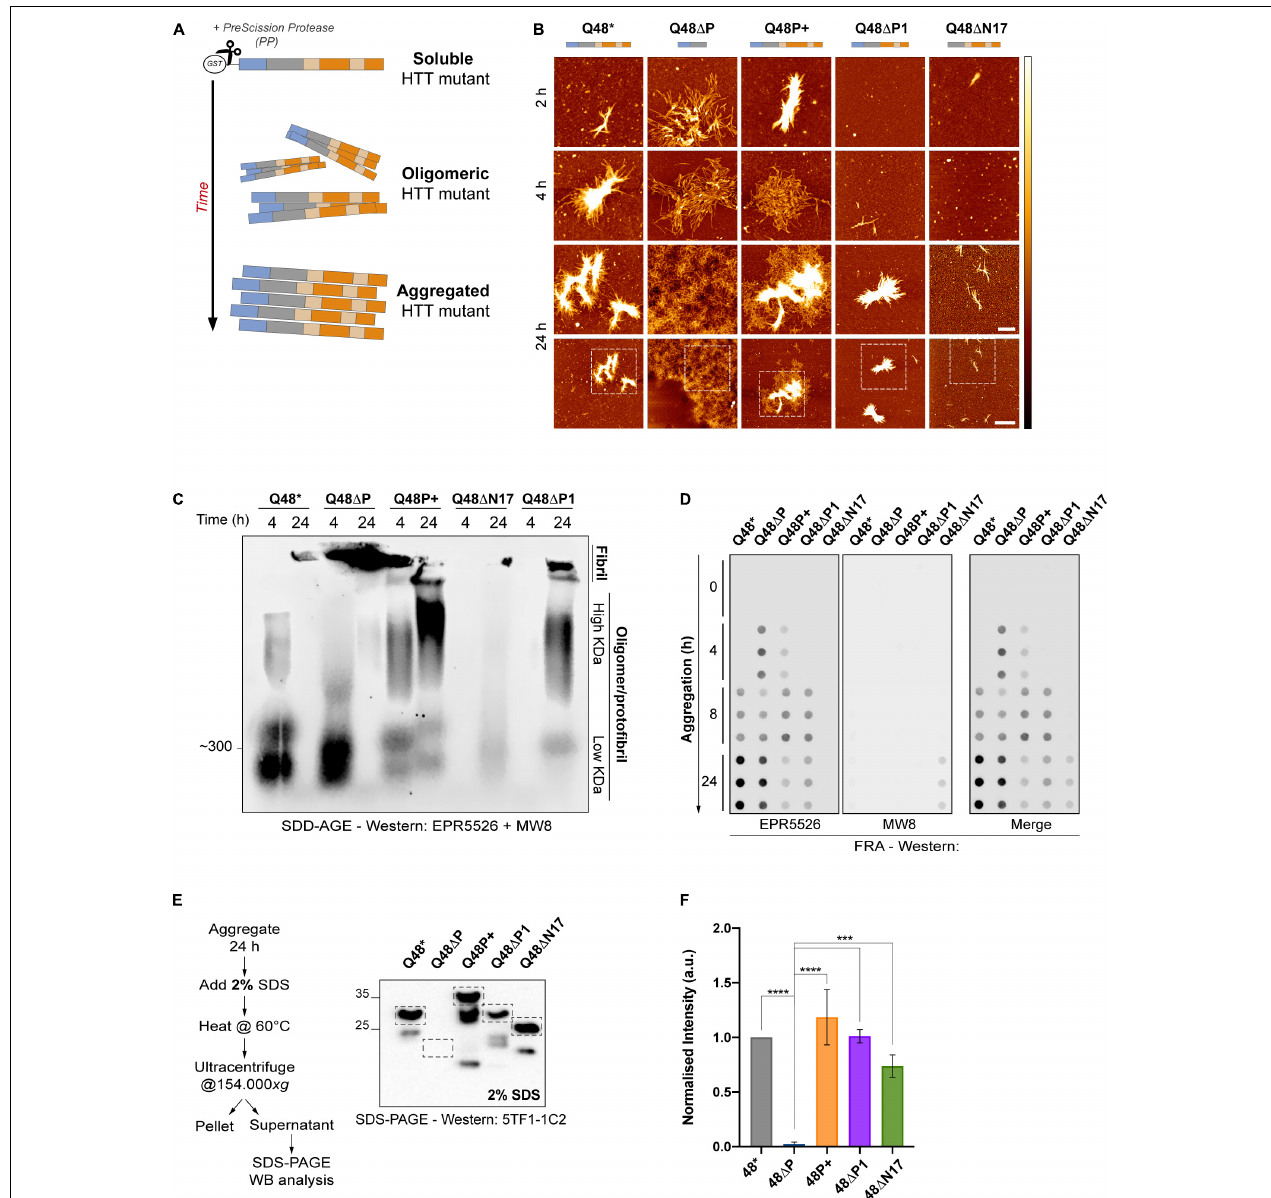
FIGURE 2 | In vitro characterization of HTTEx1 mutant reveals a high aggregation potential for constructs without the PRD and with expanded prolines. (A) Schematic of the in vitro experimental set-up employed for all assays pictured herein. HTTEx1 mutants are purified fused to a GST-tag. Upon addition of the PreScission protease (PP), the GST-tag is cleaved and HTTEx1 moieties begin their aggregation process, transitioning from a soluble to an oligomeric and into a higher order aggregated structure. (B) AFM images of spontaneous HTTEx1 mutant aggregates and their unique morphology, at 2, 4 or 24 h after addition of PP. White to black color gradient represents 0 to 15 nm height. Scale bar for top three rows is 500 nm. Fourth row represents the wider field of view of scans in row three obtained at 24 h, scale bar is 2 µ m. Dashed boxes represent the region of interest selected and magnified in the third row. (C) SDD-AGE of HTTEx1 mutants at 4 and 24 h after addition of PP. Lanes represent the different species of high molecular weight structures generated by each mutant: fibrillar species are at the top, trapped in the gel pockets, smears represent high molecular weight oligomeric/protofibrillar species, and lower signals are low molecular weight oligomers. Immunoblot stained with both the N17 specific EPR5526 and proline-binding MW8 antibodies. Gel shown here is representative of at least three independent replicates. (D) FRA showing the different time-dependent aggregation kinetics of HTT mutants. Samples were taken at 0, 4, 8 and 24 h after addition of PP and loaded in triplicates. Immunoblot was performed simultaneously with both the N17 specific EPR5526 antibody (left panel) or the MW8 proline region specific antibody (middle panel); right panel shows the merge of both. Blots are representative of at least three independent repeats. (E) Descriptive graphical abstract and Western blot analysis of the SDS stability assay. Blots represent the amount of soluble HTTEx1 present upon treatment with 2% SDS after 24 h of aggregation. Immunoblot stained for the polyQ-specific 5TF1-1C2 antibody. Bands utilized for quantification are boxed; lower bands represent truncated species and were not quantified. Shown here is one of three independent repeats. (F) Quantification of three independent SDS-SA, as per example shown in (E) . Values are normalized to Q48* and show mean ± SD; statistical significance was calculated using an ordinary one-way ANOVA followed by Tukey post hoc test and assuming 95% confidence interval ( ∗∗∗ = p < 0.0002; ∗∗∗∗ = p < 0.0001